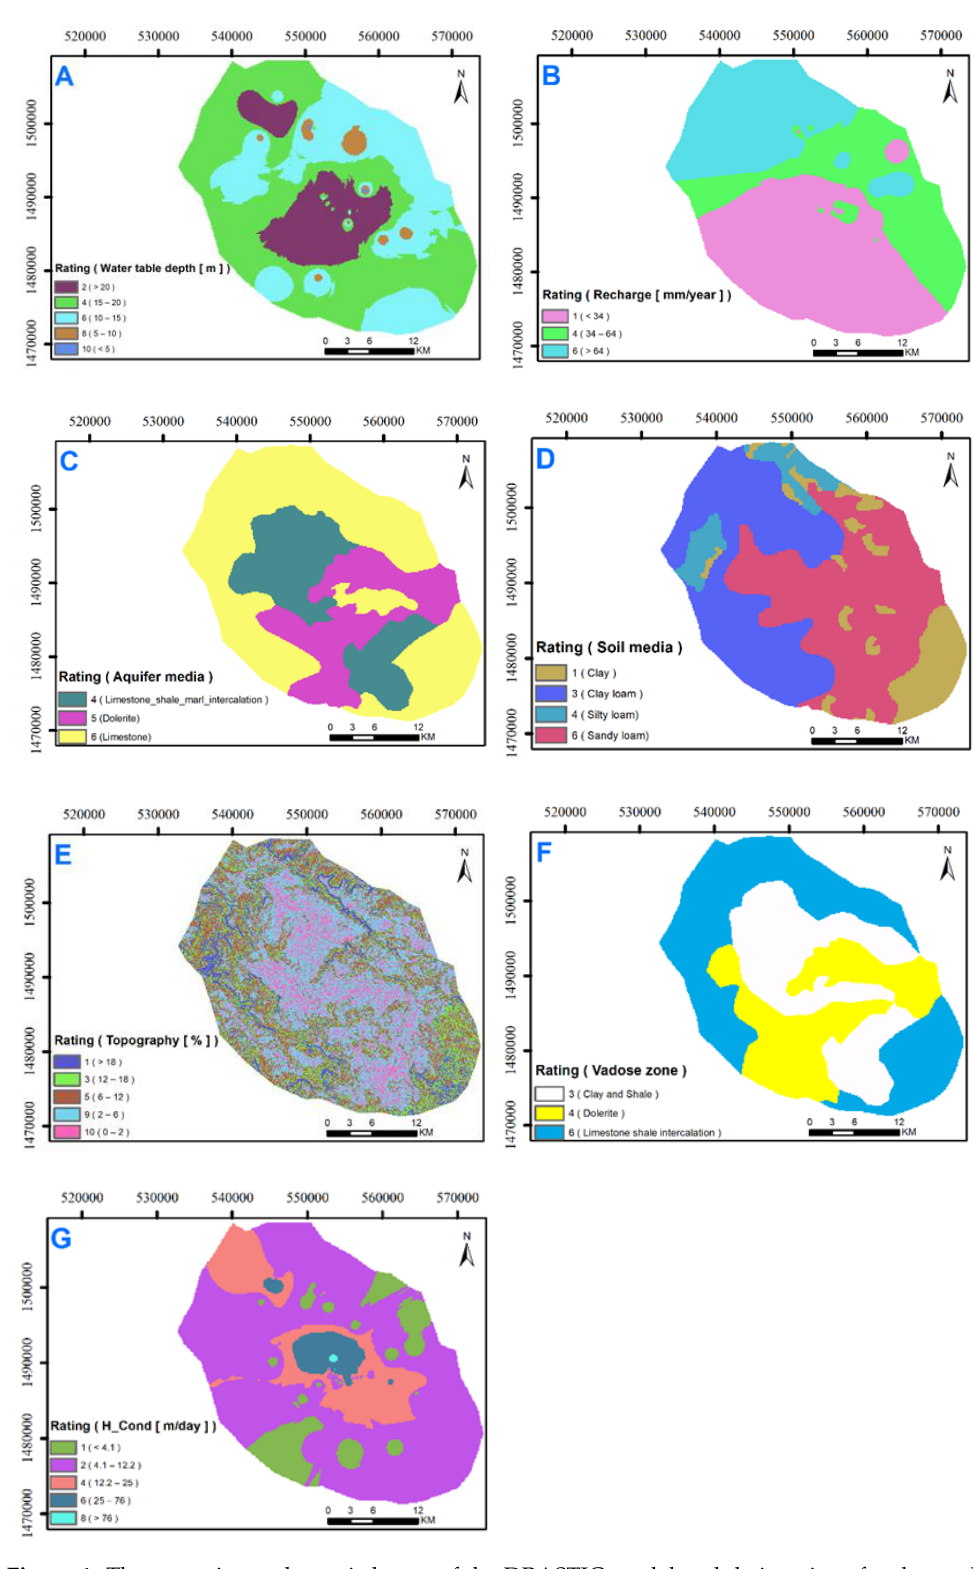
Figure 4. The seven input thematic layers of the DRASTIC model and their ratings for the study area: ( A ) depth-to-water table; ( B ) net recharge; ( C ) aquifer media; ( D ) soil media; ( E ) topography; ( F ) vadose zone; and ( G ) hydraulic